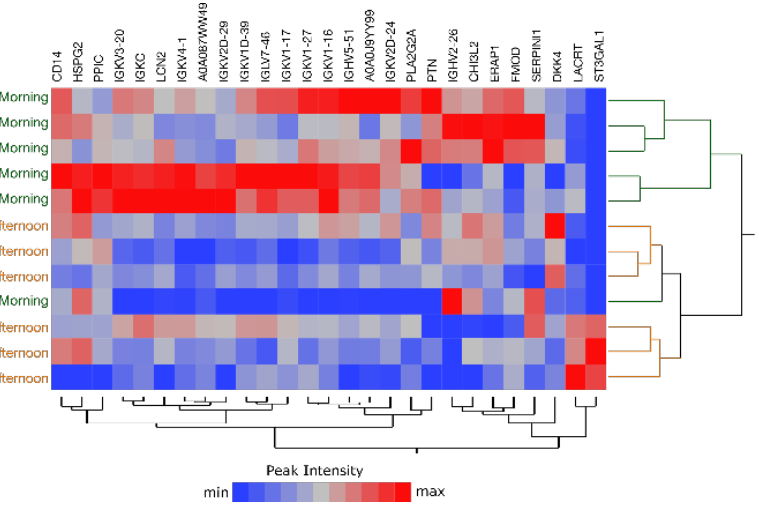
Figure 10. Double-hierarchical clustering analysis of 27 tear proteins selected by LDA and 12 samples (green, morning; orange, afternoon). LFQ by peak intensity is represented by a color code from blue to red, according to increasing abundances. Samples were collected weekly from two subjects over three weeks.